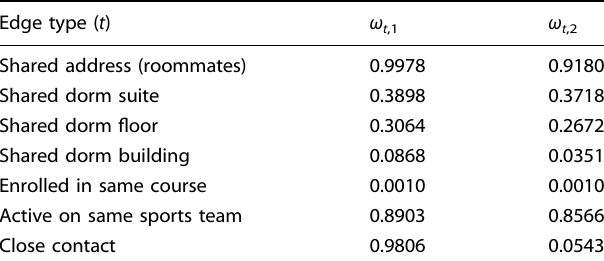
Table 3. Edge type weights learned by the node risk prediction model. These weights ( ω t , i ) are utilized in Eq. 1. Each value represents the risk for a student given that they share an edge of type t with another student at i hops in the